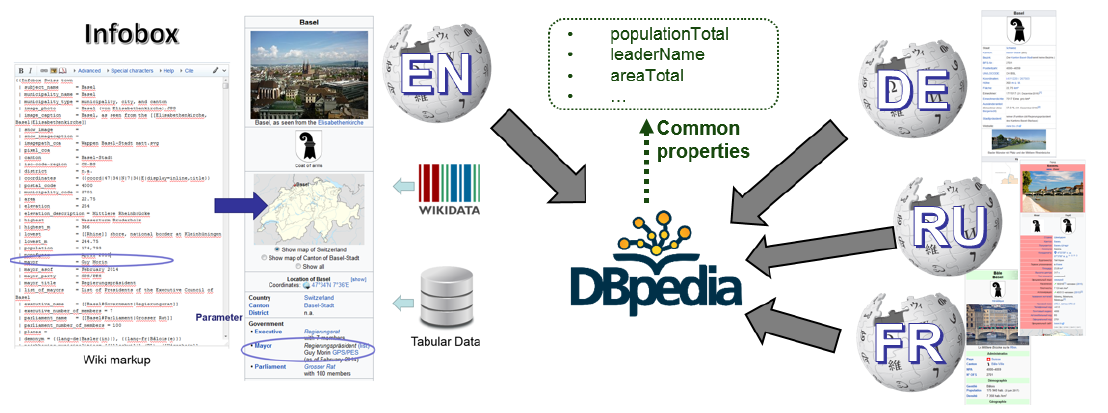
Figure 6. Infobox about Basel with its data sources and its extraction to DBpedia from different Wikipedia language